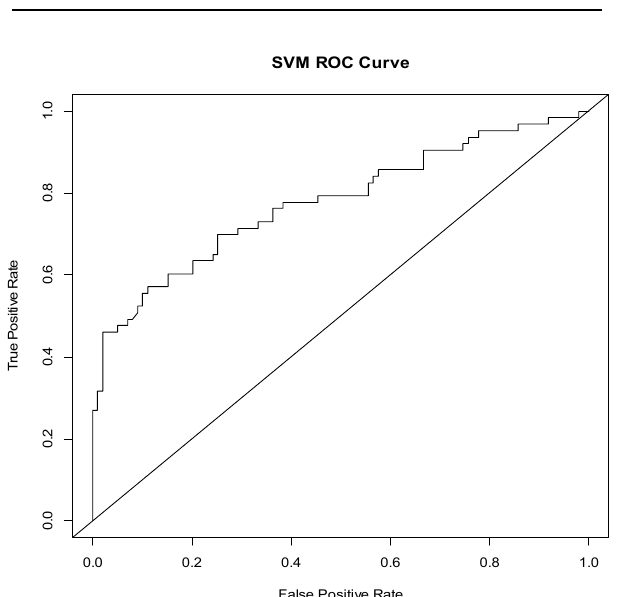
Figure 4. Performance evaluation of the combined classifier using Receiver Operating Characteristic (ROC) Curve and Area Under Curve (AUC = 0.778).